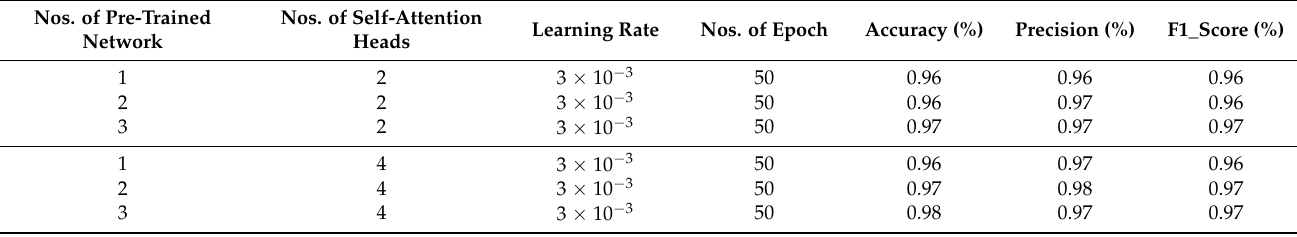
Table 6. Parameter sensitivity analysis of